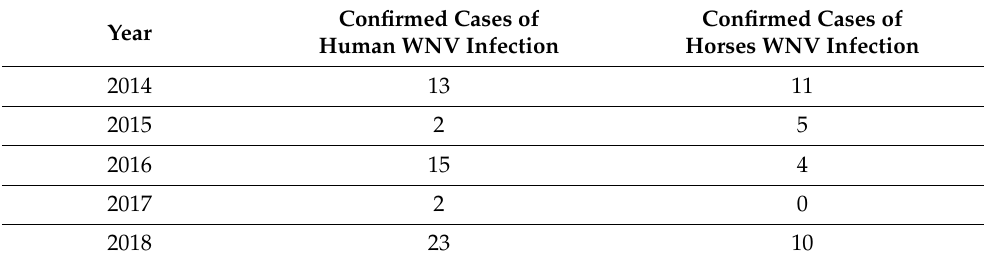
Table 4. Confirmed cases of human and horse West Nile Virus